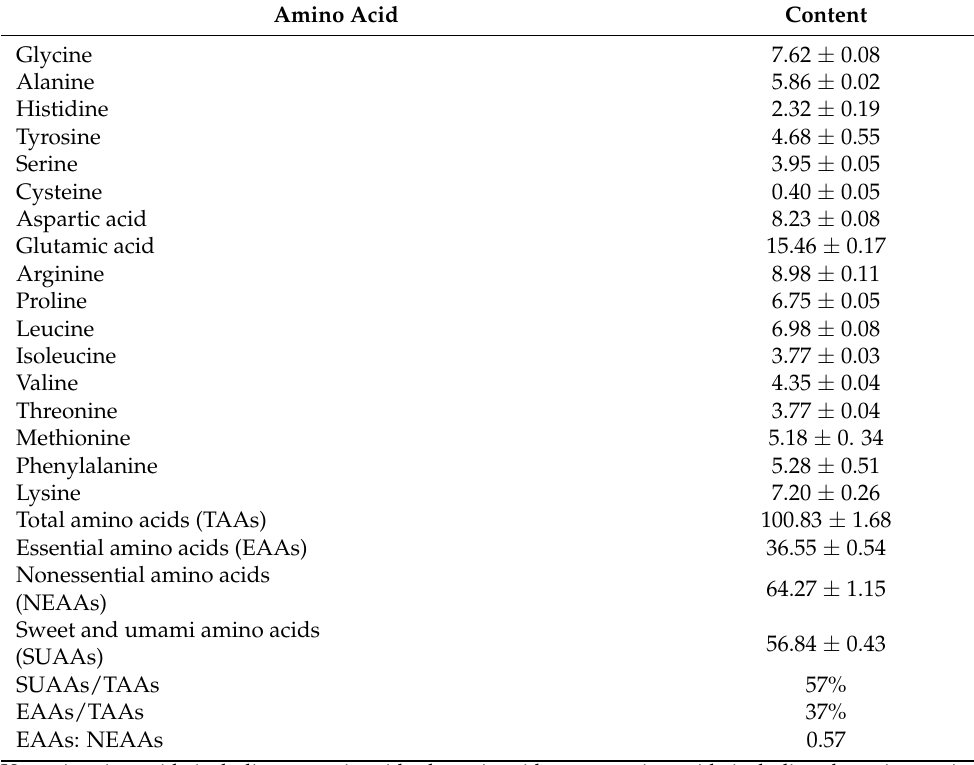
Table 3. Composition of amino acids in shrimp head (wet basis, mg/g).